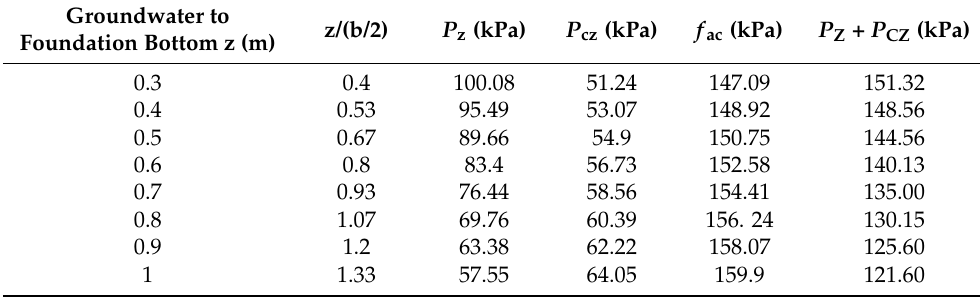
Table 6. Calculation results of foundation bearing capacity (b = 1.5 m, d = 2.5 m).